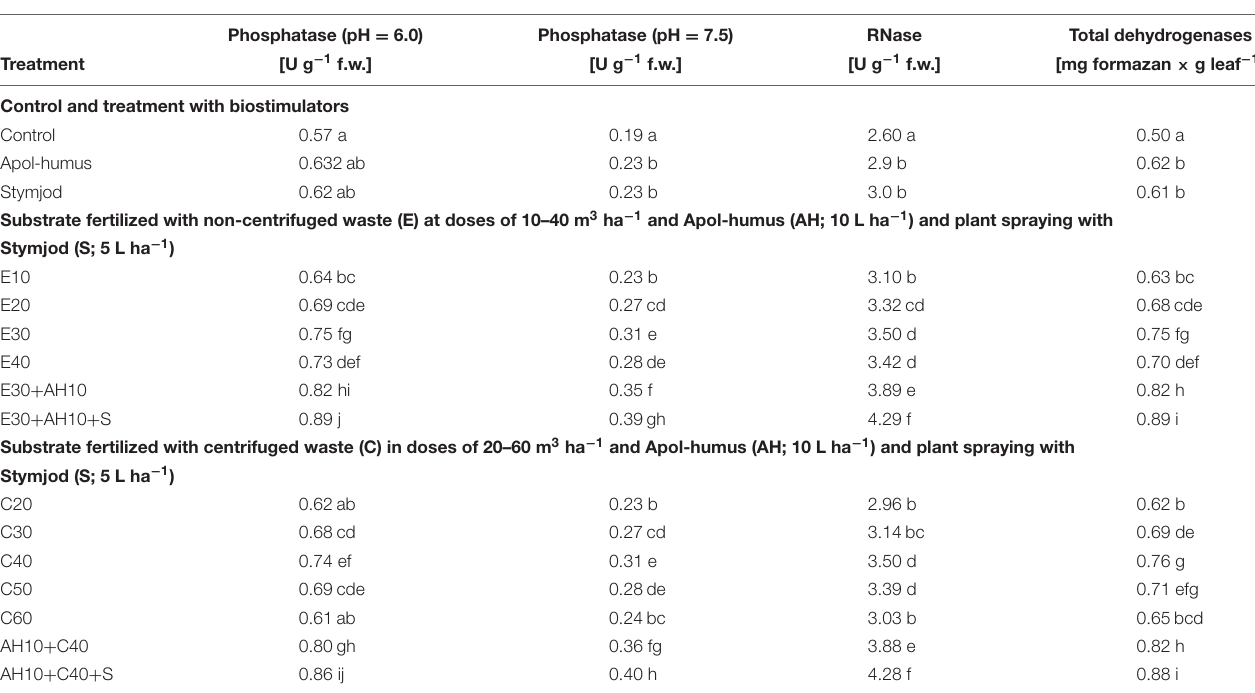
TABLE 6 | Activity of selected enzymes in leaves of sorghum plants cultivated in pots and fertilized with liquid, non-centrifuged and centrifuged waste from a biomass biodigestion to methane, Apol-humus and Stymjod. Phosphatase (pH =